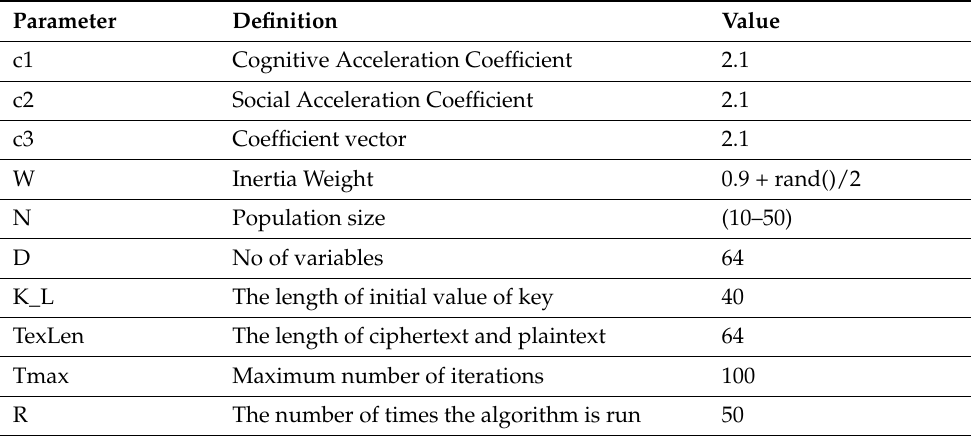
Table 2. The BHPSOEO parameters to attack RC4 cipher with Textlen 64 bits.